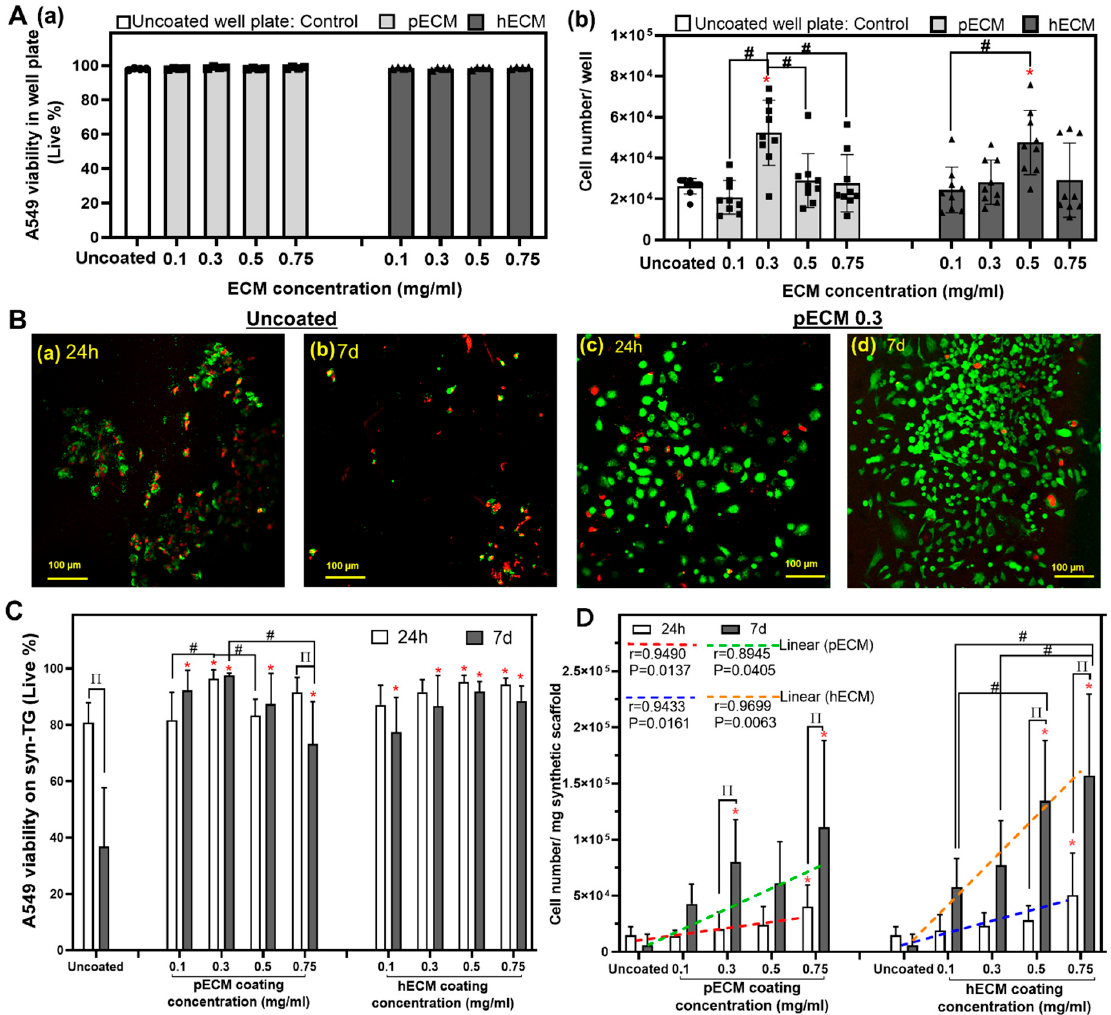
Figure 2. Cell viability and cell numbers in the pECM- and hECM-coated well plates and syn-TG in vitro. ( A ) The impact of pECM and hECM coatings on the cell viability and recovery in 2D well plates. (a) Viability of the cells in uncoated and coated well plates. No effect was seen at 24 h. (b) Recovered cell numbers in the 2D well plate. * Represents that the coated well plate with pECM 0.3 mg/mL and hECM 0.5 mg/mL increased the proliferation compared with the uncoated well plate ( p = 0.0019 and 0.0223, respectively). # Represents a cell number increase in the pECM 0.3-mg/mL-coated well plate compared to the 0.1-, 0.5-, and 0.75-mg/mL-coated well plates ( p < 0.001 and p = 0.0084 and 0.0044, respectively). # Represents the increase in cell number in the hECM 0.5-coated well plate compared to the hECM 0.1-coated well plate ( p = 0.0092). ( B ) Representative images of live and dead cells on uncoated ((a),(b)) and pECM 0.3-mg/mL-coated scaffolds ((c),(d)) at 24 h and 7 d (other live/dead images can be found in Figure S1 in the Supplementary Materials). ( C ) Viability quantification of the cells on the uncoated and coated scaffolds at 24 h and 7 d. ∏ A decline in the viability was noted in the uncoated and pECM 0.75 mg/mL from 24 h to 7 days ( p < 0.0001 and p = 0.494, respectively). # The increased viability of pECM 0.3 compared to pECM 0.1 and pECM 0.5 at 24 h ( p = 0.0019 and 0.0081, respectively); at 7 d, there was a lower cell viability with the pECM 0.75-coated scaffold compared with the pECM 0.3-coated scaffold ( p = 0.0162). * Represents the improvements in the viability of the coated scaffolds at 24 h compared to the uncoated (pECM 0.3, p < 0.001; hECM 0.5, p = 0.0026; and hECM 0.75, p = 0.0057); at 7 d, all the concentrations of the pECM and hECM coatings enhanced the cell viability compared to the uncoated scaffold ( p < 0.001). ( D ) The cell numbers on the scaffold after 24 h and 7 d. At 24 h, * the scaffolds coated with pECM 0.75 and hECM 0.75 mg/mL showed higher cell numbers compared with the uncoated ( p = 0.0387 and 0.0059, respectively). At 7 d, the scaffolds coated with pECM 0.3 and pECM 0.75 and hECM 0.5 and hECM 0.75 mg/mL all demonstrated higher recovered cell counts compared with the uncoated scaffold ( p = 0.0282 and p < 0.001 for pECM and p < 0.0001 for hECM). There was a correlation between the concentration of both the pECM and hECM coatings with the cell number at 24 h (pECM: r = 0.9490, p = 0.0137; hECM: r = 0.9433, p < 0.0161) and at 7 d (pECM: r = 0.8945, p < 0.0405; hECM: r = 0.9699, p <